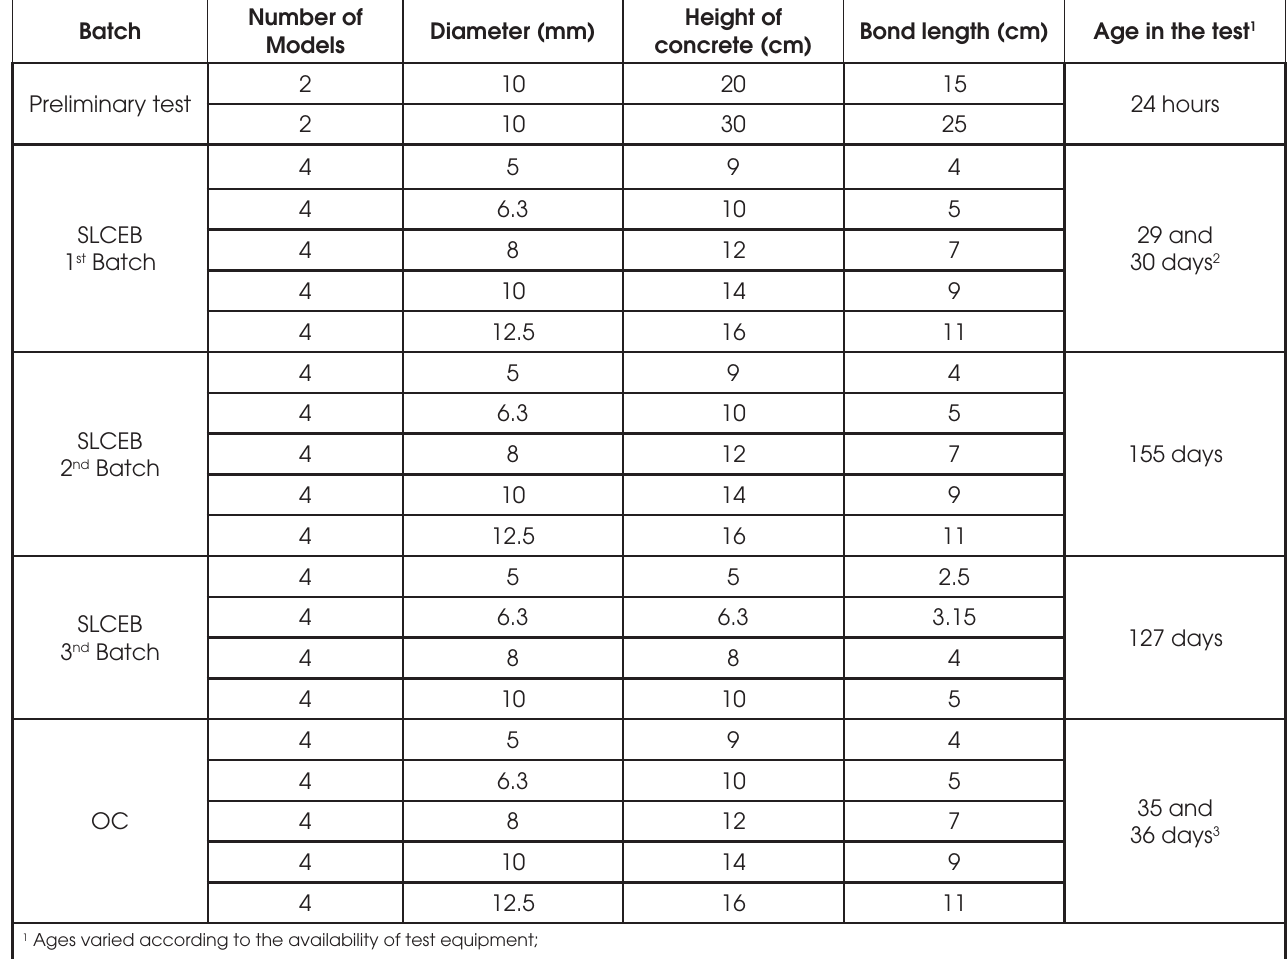
General characteristics of specimens of pull-out